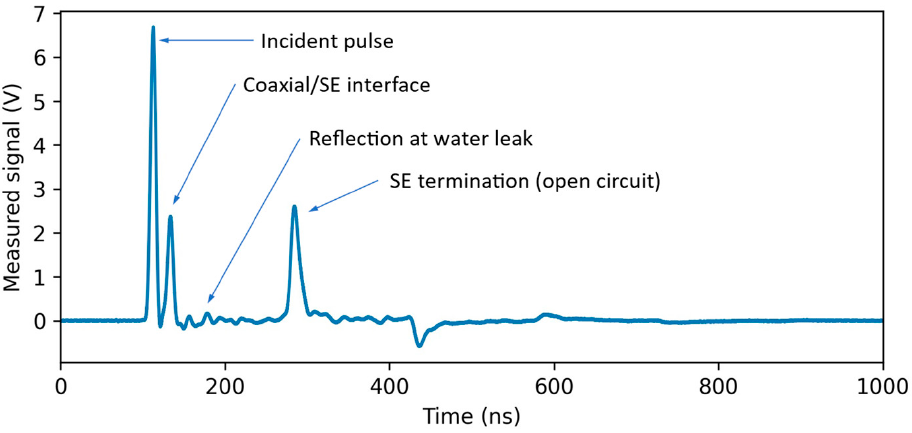
Figure 2. Typical reflectogram associated to the on-field measurement setup schematized in Figure 1, when an impulsive transmitted signal is used by the TDR unit.